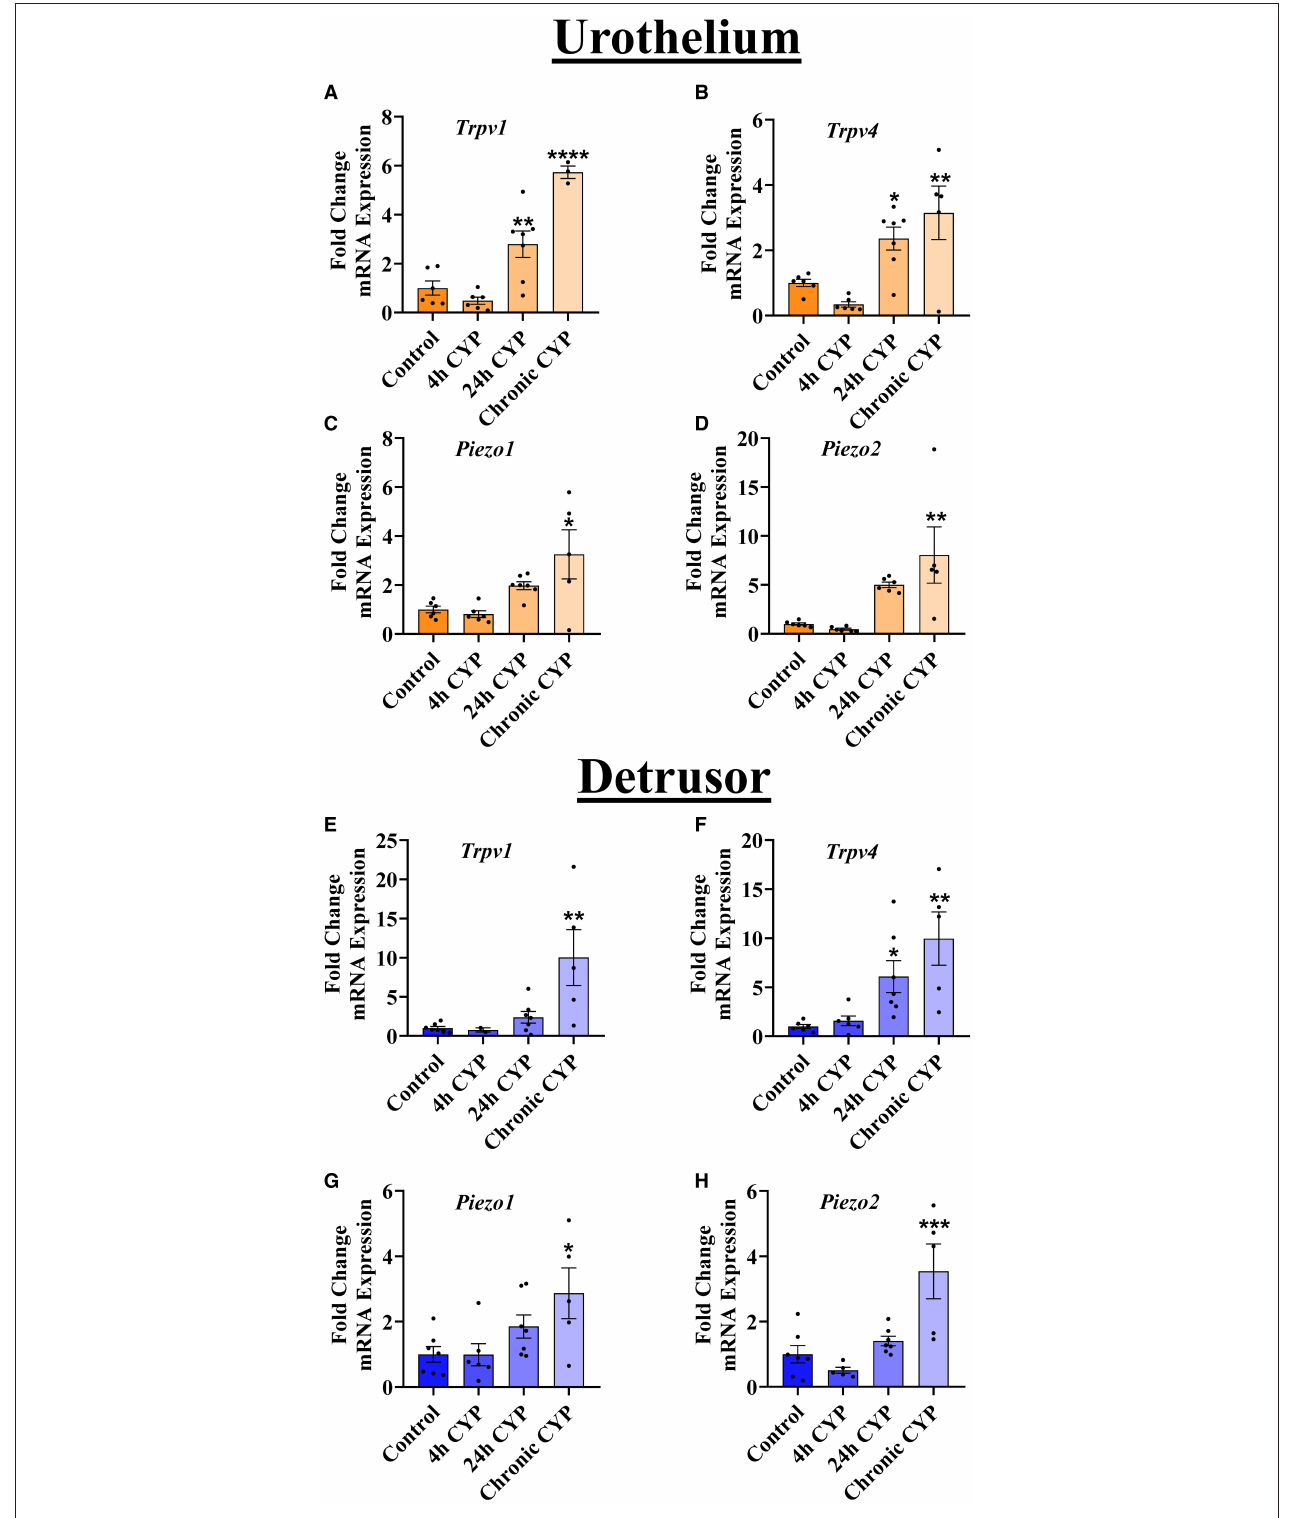
FIGURE 2 | Chronic, but not acute, CYP-induced cystitis leads to increases in MSC gene expression. RT-qPCR was used to detect MSC mRNA separately in the urothelium and the detrusor layers of the urinary bladder at several timepoints of CYP treatment. (A–D) In the urothelium, Trpv1 ( n = 3–7) and Trpv4 ( n = 5–7) mRNA were significantly upregulated after 24h CYP-treatment ( P ≤ 0.01 and P ≤ 0.05, respectively) and after chronic CYP-induced cystitis ( P ≤ 0.0001 and P ≤ 0.01, respectively). Piezo1 ( n = 5–7) and Piezo2 ( n = 5–6) were both significantly increased in the urothelium only after chronic CYP-treatment ( P ≤ 0.05 and P ≤